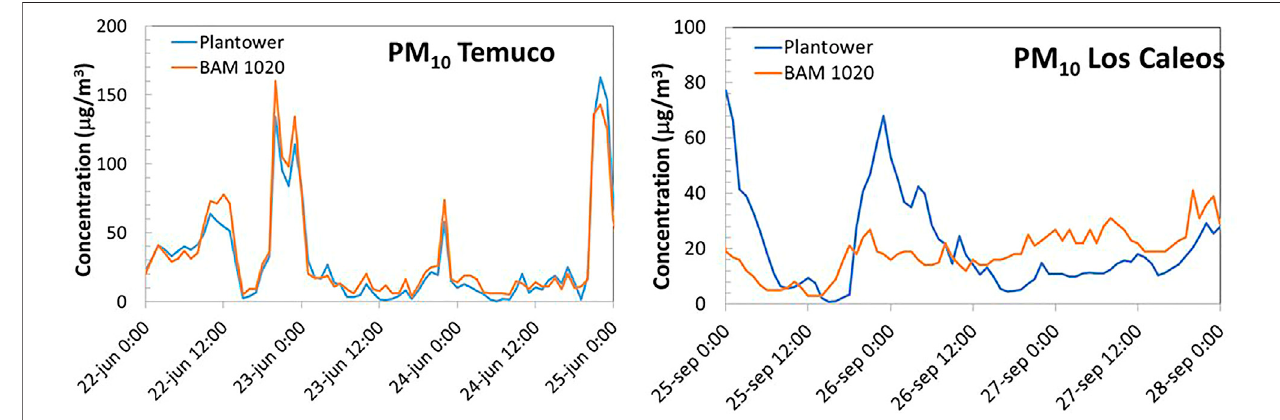
FIGURE 9 | Time series of the Plantower and Beta monitors in Temuco and Los Caleos. Large under- and over-estimations of PM 10 are seen in Los Caleos, a site with high relative concentrations of dust, sulfate and chloride.